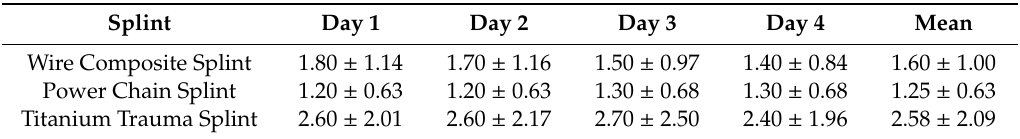
Table 4. Irritation of lips and cheeks.